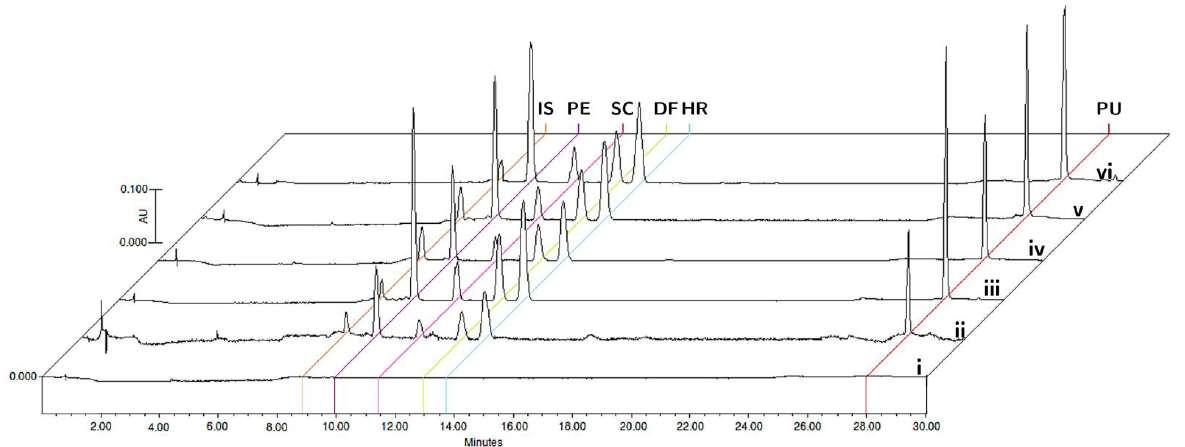
Figure 2. Representative chromatograms of (i) blank matrix, (ii) blank matrix spiked with LLOQ concentration, and processed samples collected at 15 min after oral administration of standardized hexane extract spiked with IS in plasma (iii), brain (iv), kidneys (v), and spleen (vi).